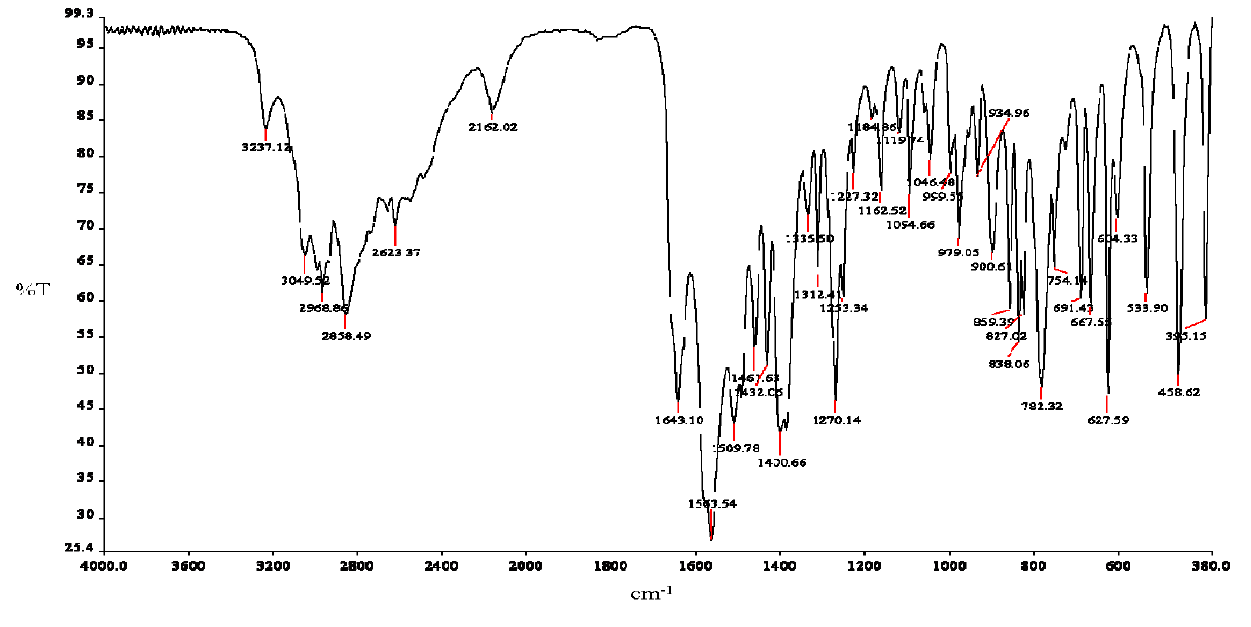
Figure 4. ATR-IR spectrum of L -carnosine.